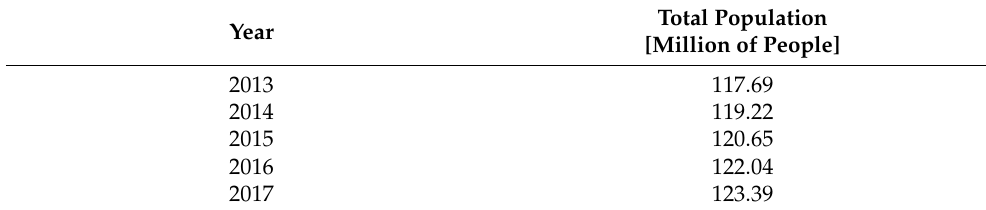
Table 1. Historical population in the middle of the year for Mexico. Source: [26].